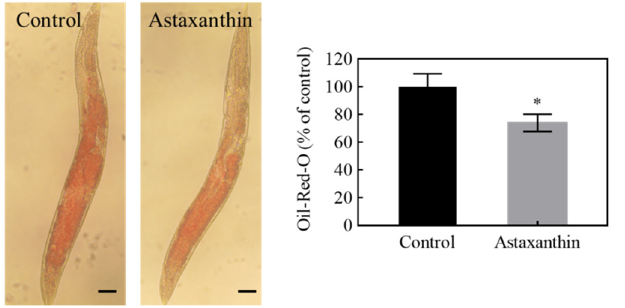
Figure 6. Effects of astaxanthin on fat accumulation in C. elegans. Worms synchronized to the adult stage were treated with or without astaxanthin for 6 days and stained with Oil Red O. Image ‐ Pro Plus was used to quantify the intensity of Oil Red O staining. Scale bar: 100 μ m. Data were expressed as mean ± SE. * Significantly different from the control worms ( p < 0.05).